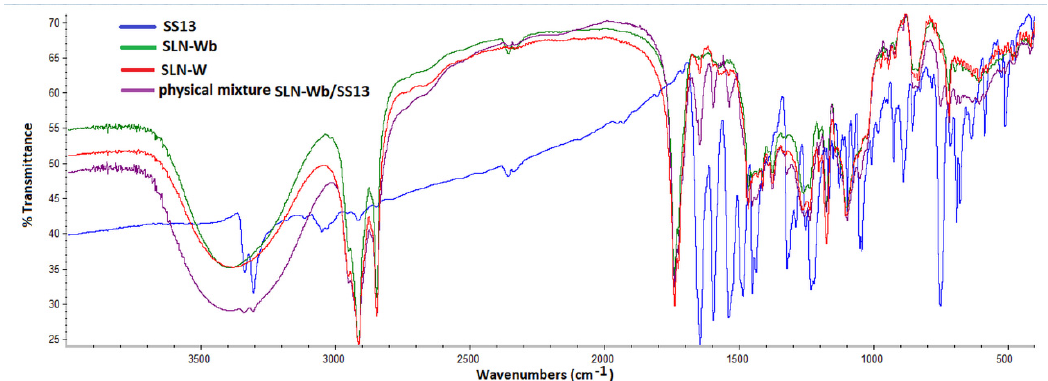
Figure 6. FTIR spectra of SS13, SLN-Wb, SLN-W and physical mixture of SLN-Wb and SS13.